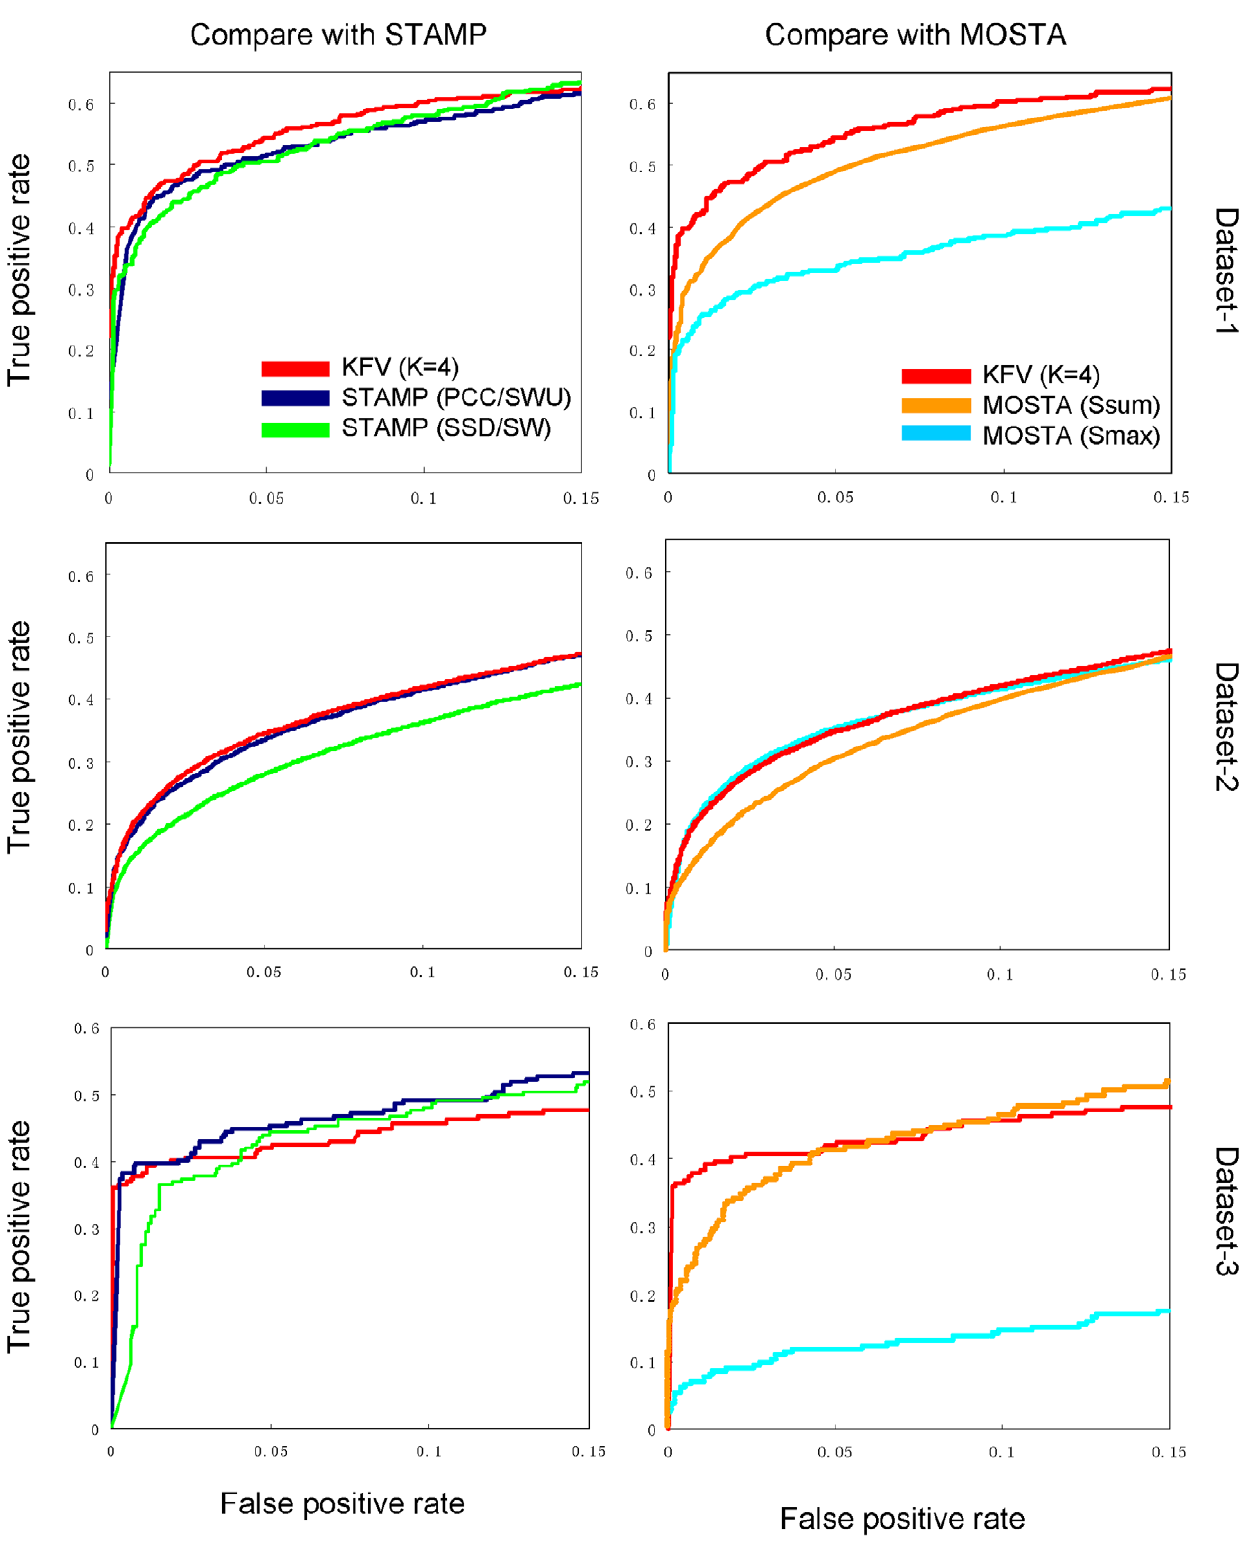
Figure 1. Evaluation of three motif comparison algorithms using ROC curves. The ROC curves were plotted based on three datasets in Table 1.